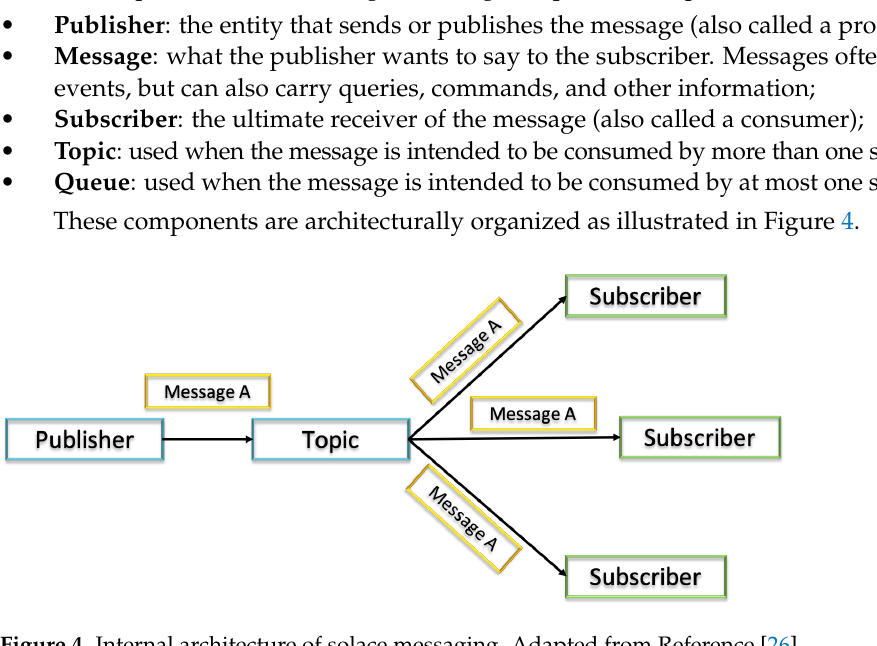
Figure 4. Internal architecture of solace messaging. Adapted from Reference